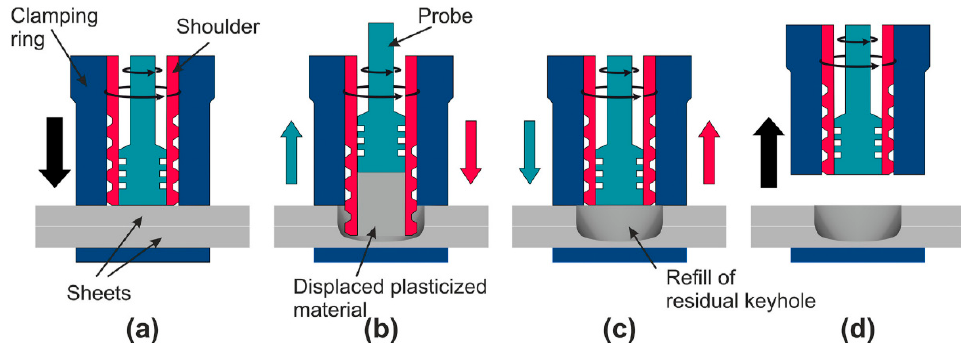
Figure 9. Schematic representation of the shoulder-plunge refill FSSW mode: ( a ) clamping of the sheets, ( b ) shoulder plunging and probe retraction, ( c ) shoulder and probe reaching back to the sheet’s surface and refilling the keyhole, and ( d ) releasing of the clamping force and tool set lifting [80] .